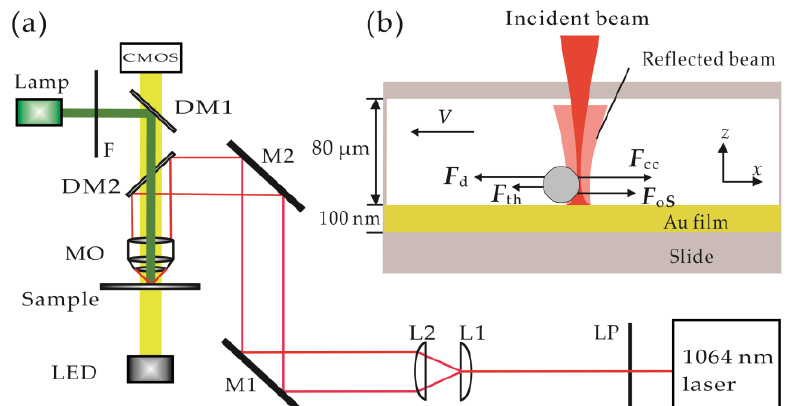
Figure 1. ( a ) Experimental setup. Trapping part (red): trapping laser beam is expanded and focused into the sample volume by a microscope objective. Fluorescence part (green): light of a mercury lamp is filtered and focused into the sample volume. Emitted fluorescent light is collected by the same microscope objective and recorded by a CMOS camera. Imaging part (yellow): the sample is illuminated by a LED and imaged by the same CMOS camera. LP, liner polarizer; L1-L2, lens; M1-M2, mirrors; F, Filter; DM1-DM2, dichroic mirror; MO, microscope objective; CMOS, CMOS camera; ( b ) Schematic description of optothermal trap and forces on a microparticle close to the gold film. The laser is focused before being reflected by the gold film. The optothermal trap is combined with an optical trap and a thermal trap. When the stage is moving at a velocity V , a viscous drag force F d from liquid is exerted on the microparticle. F cc , convective drag force; F oS , optical trapping force of standing-wave trap; F th , thermophoretic force.